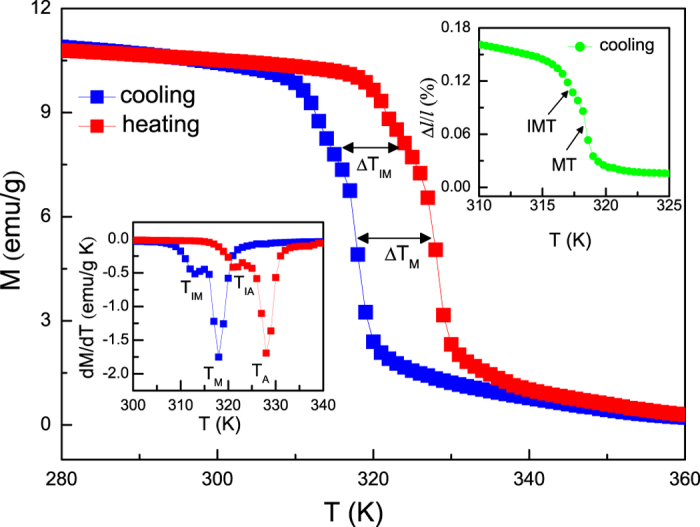
Temperature dependence of magnetization M(T) for Ni55.8Mn18.1Ga26.1 alloy on cooling and heating at magnetic field of 500 Oe.Left lower panel shows the dM/dT(T) curves corresponding to these transformations. Right upper panel shows the strain as a function of temperature Δl/l(T) in the absence of magnetic field upon cooling.